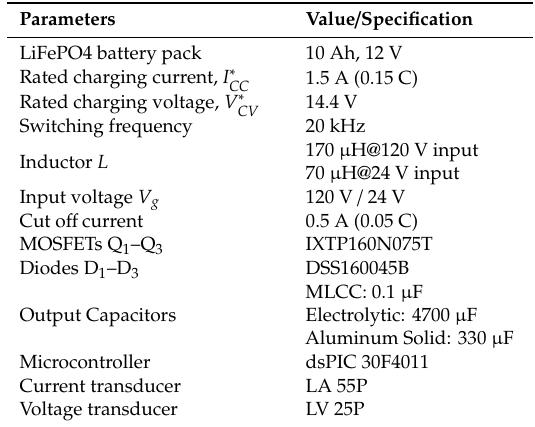
Table 2. Circuit parameters of the constructed prototype.